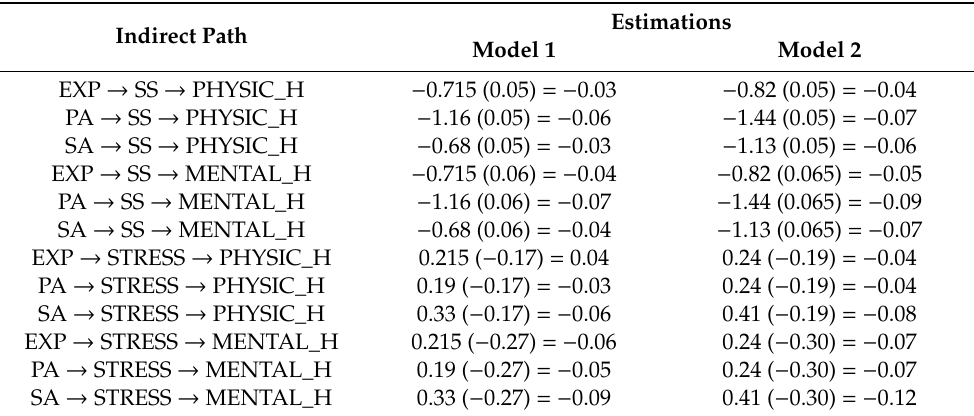
Table 3. Parameter estimates of indirect e ff